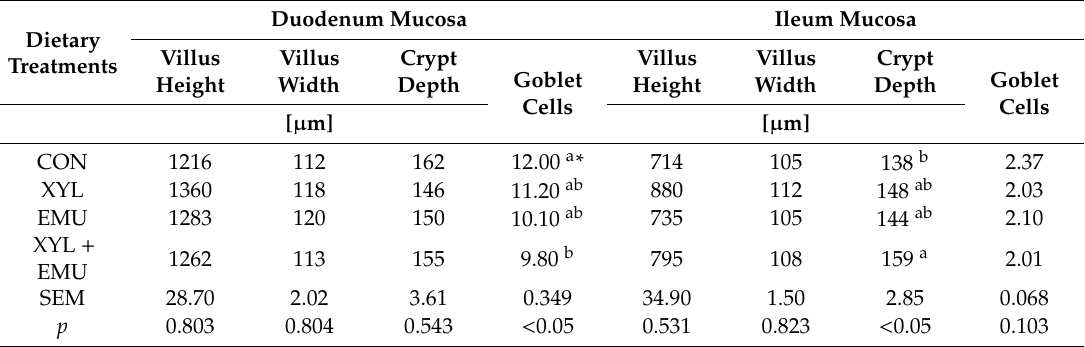
Table 5. Morphometry of duodenum and ileum mucosa in birds fed control (CON), control supplemented with xylanase (XYL), control supplemented with an emulsifier (EMU), and control diet supplemented with xylanase and emulsifier XYL +